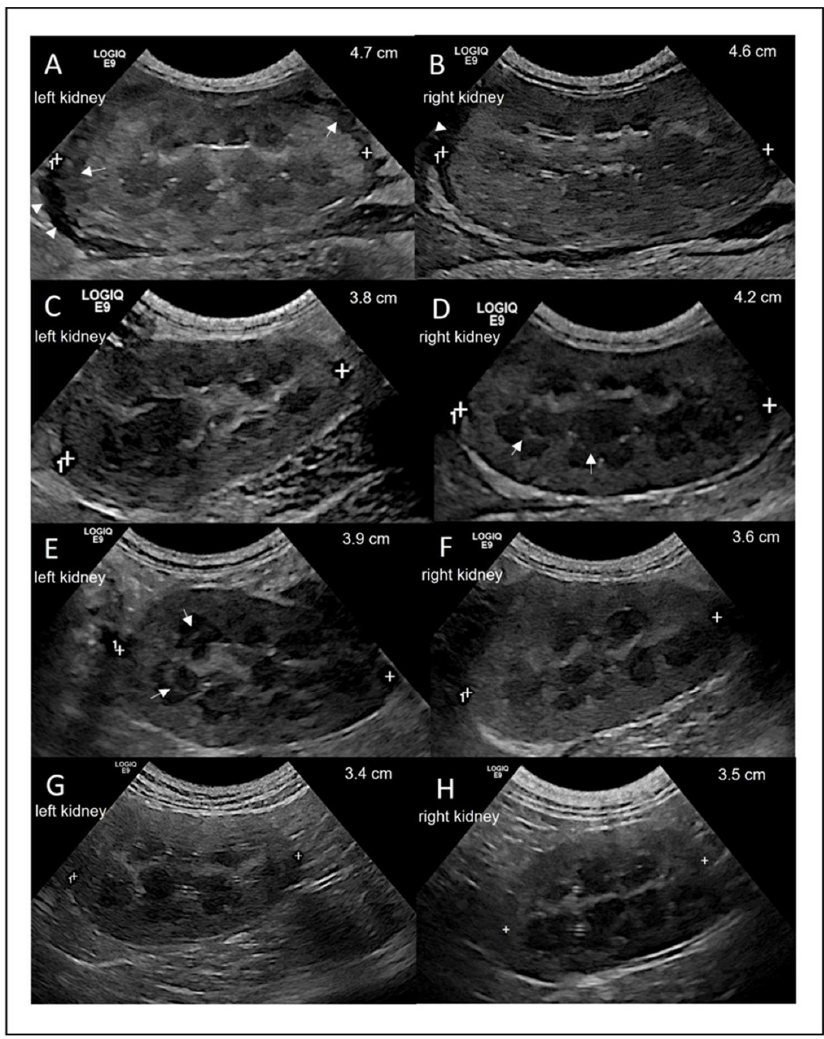
Figure 3. Ultrasonographic longitudinal view of the left and right kidney on days 0, 7, 14, and 168. ( A , B ) Day 0 with arrow heads showing free fluid in the retroperitoneal area and arrows showing hypoechoic subcapsular rim. ( C , D ) Day 7 with arrows showing the medullary rim sign. ( E , F ) Day 14 with arrows showing the medullary rim sign. ( G , H ) Day 168 with normal size, structure, texture, and echogenicity.